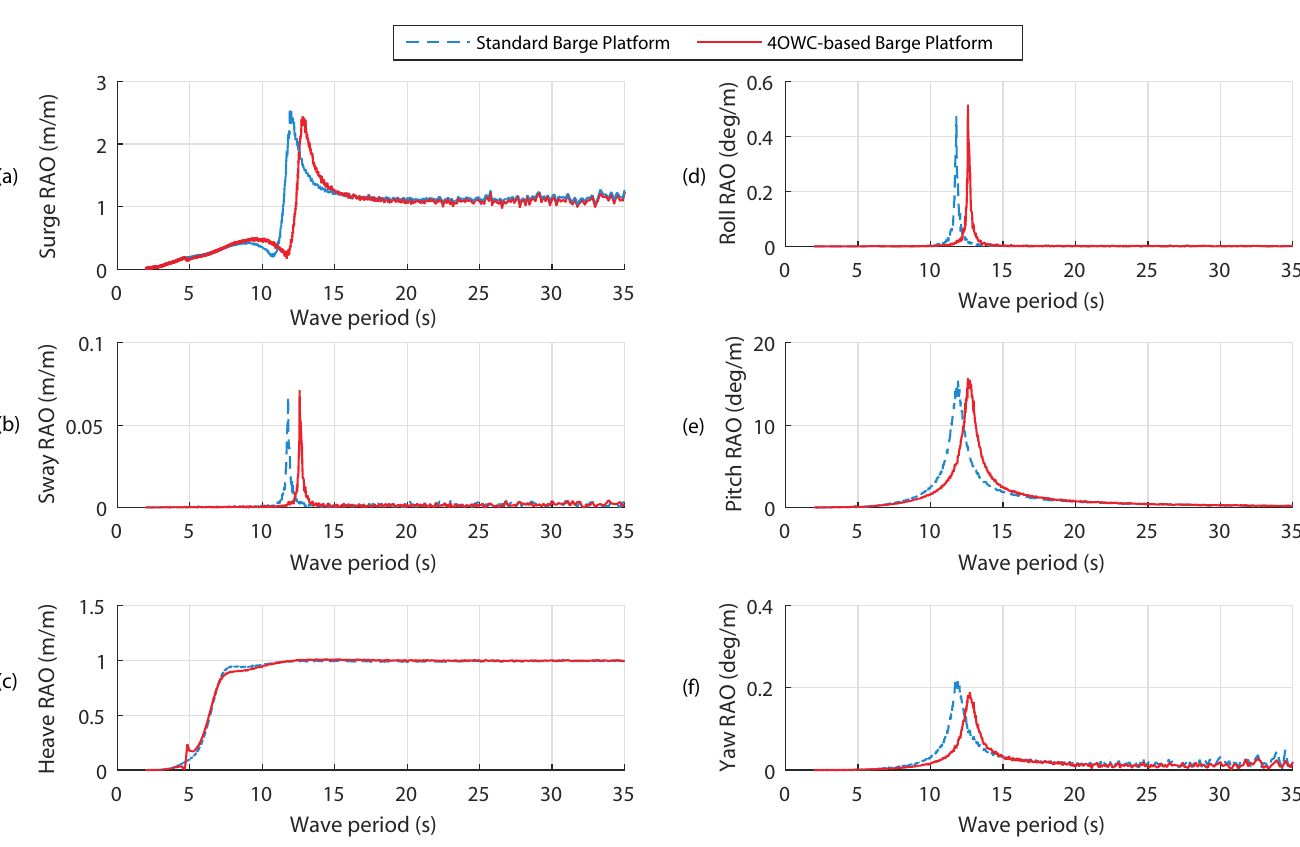
Figure 5. RAOs for ( a ) Surge, ( b ) Sway, ( c ) Heave, ( d ) Roll, ( e ) Pitch and ( f ) Yaw.